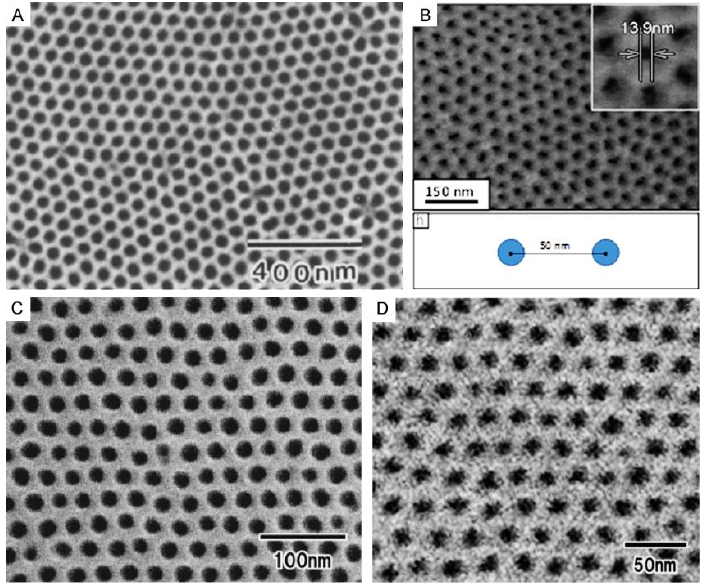
Figure 33. ( A ) A self-ordered PAA layer with ≈63 nm periodicity formed in 0.3 M H 2 SO 4 solution at 0 °C and ∆ U = 27 V (see Refs. [2,69]); ( B ) Interpore distances reduced down to ≈50 nm by